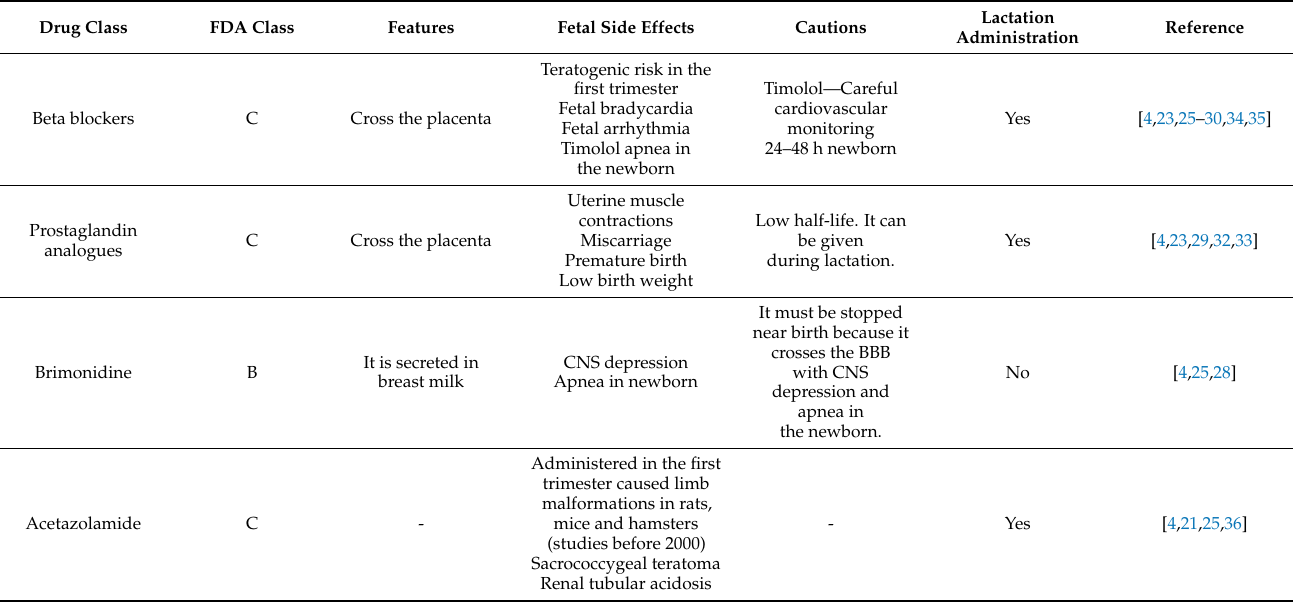
Table 4. Antiglaucoma medication and side